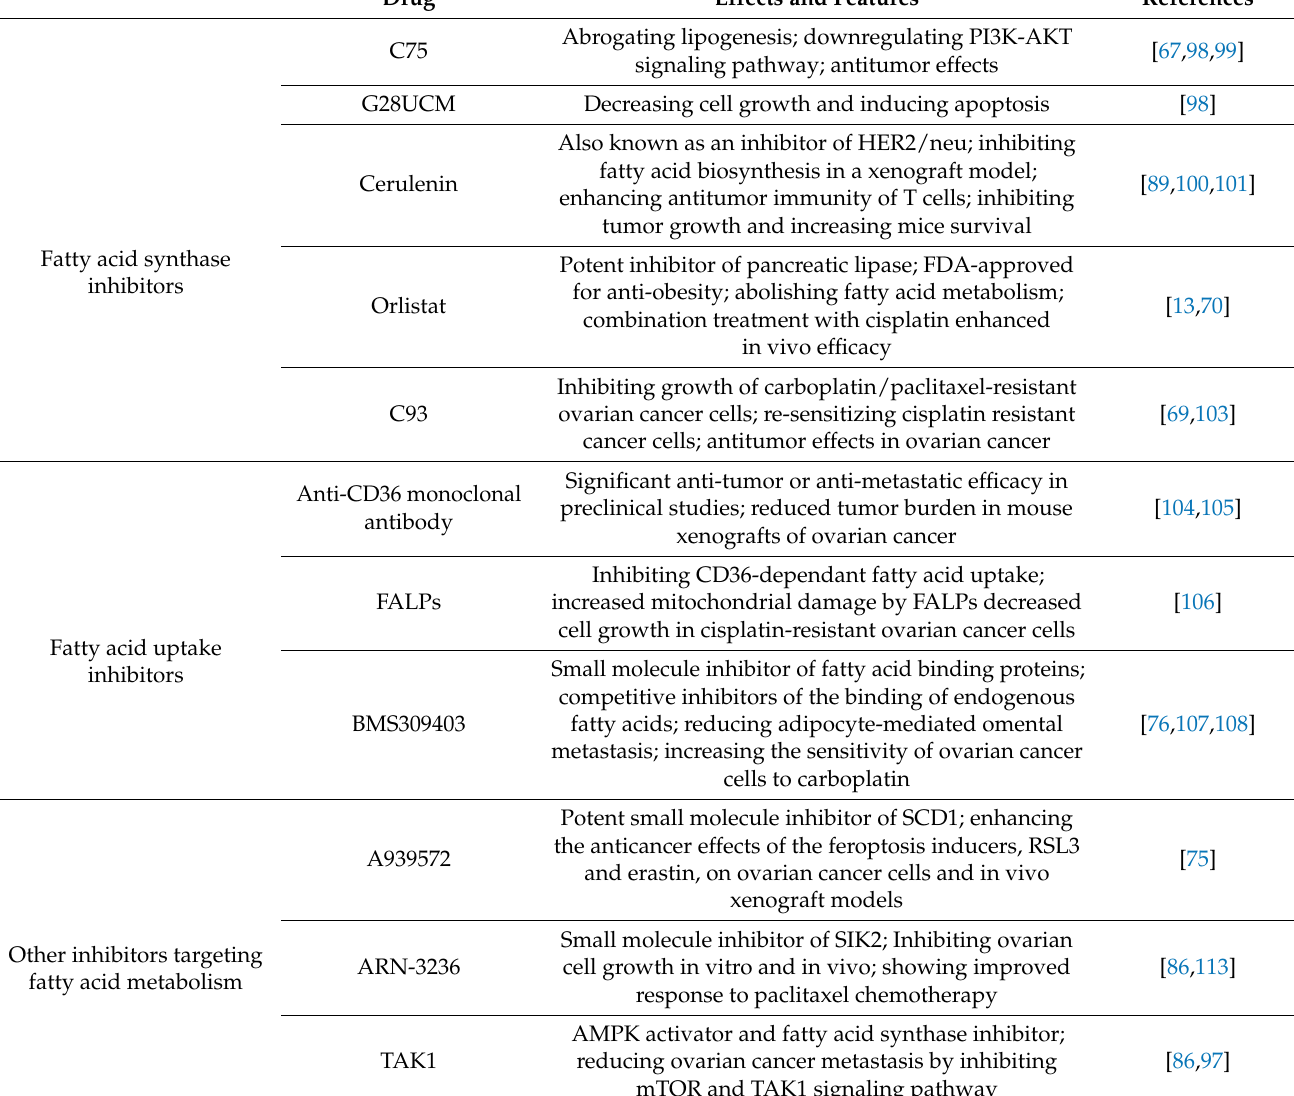
Table 1. Therapeutic strategies targeting fatty acid metabolism for ovarian cancer. Drug Effects and